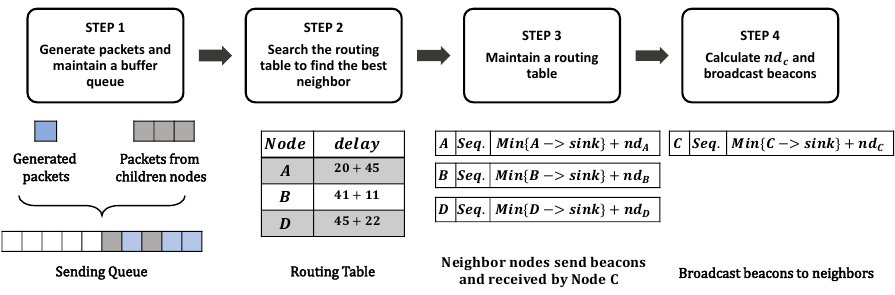
Figure 5. The routing selection procedure of Node C